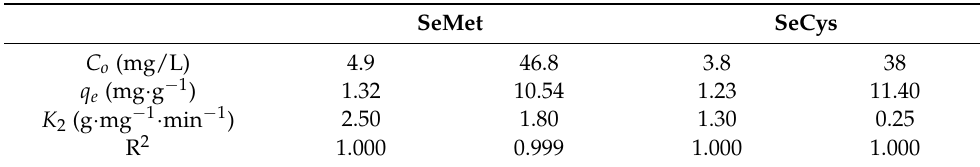
Figure 5. Effect of initial concentration by GAC: ( a ) SeMet ( C o : 46.8 and 4.9 mg/L); ( b ) SeCys ( C o : 38 and 3.8 mg/L); all experiments were conducted at pH 7.0, 7 g/L and 25 ◦ C. Table 2. Experimental data for adsorbate initial concentration studies with GAC adsorbent, at pH 7.0.